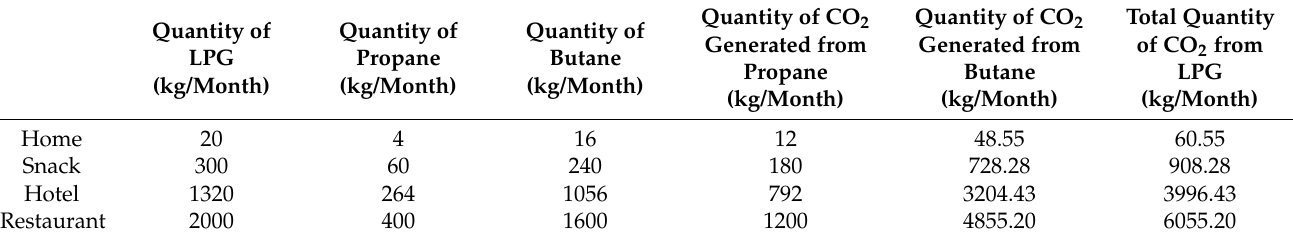
Table 1. Quantity of CO 2 released into the environment from the LPG. Reprinted/adapted with permission from Ref. [18], 2018,